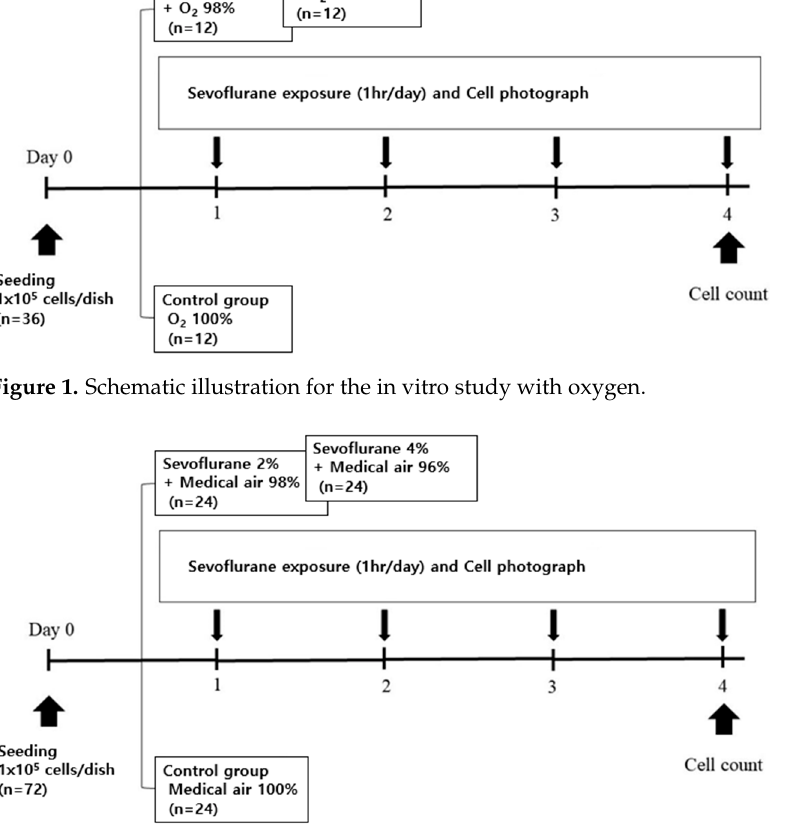
Figure 2. Schematic illustration for the in vitro study with